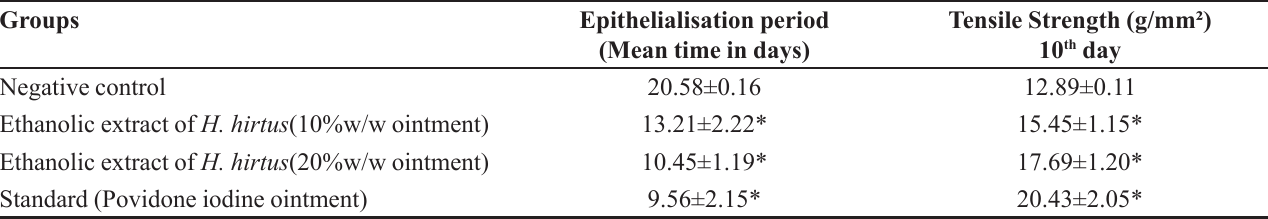
TABLE I - Effect of topical application of ethanolic extract of Hibiscus hirtus on healing of incision wound model in rabbits Groups